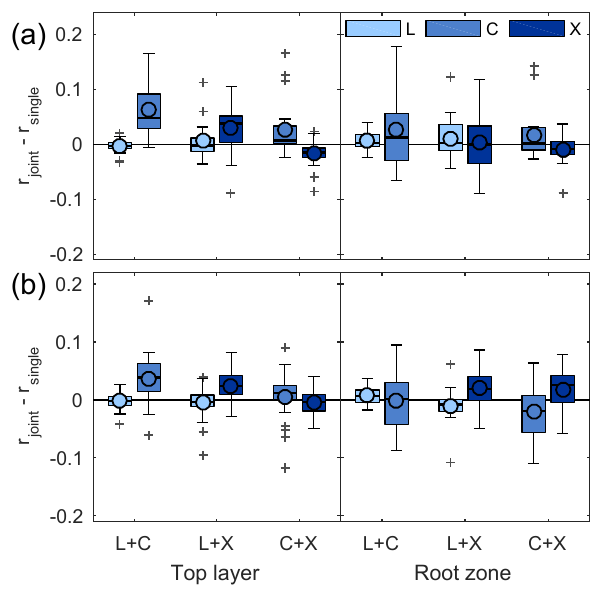
Figure 6. The difference in model performance between the joint assimilation and single-retrieval assimilation for surface ( N = 24) and root-zone ( N = 19) soil moisture (a) , where model perfor- mance is based on the correlation ( r ) between modeled and field- measured soil moisture (July 2012 to April 2015). The legend in- dicates which single-assimilation experiment is used as a reference to evaluate the joint assimilation experiments. In (b) , the same is shown for anomaly time series. Box plots are defined as in Fig.